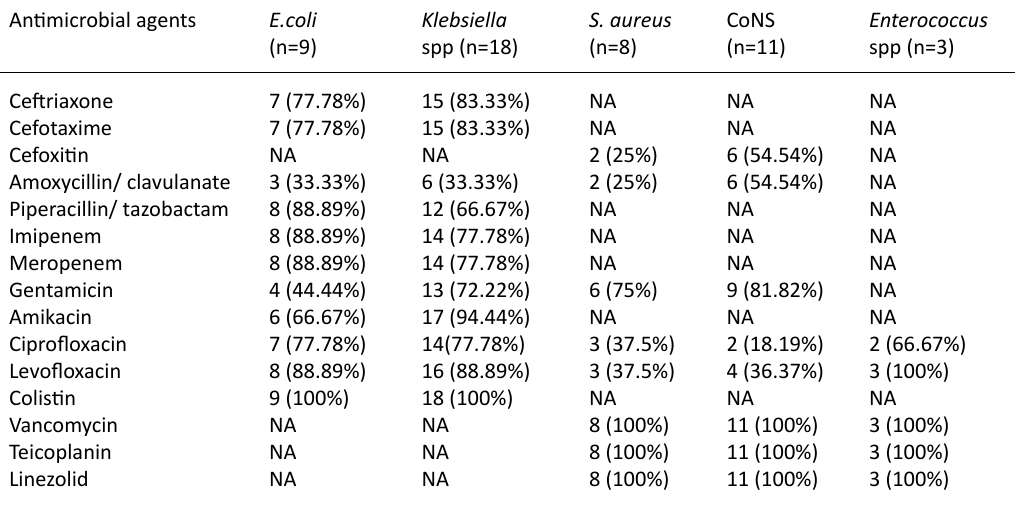
Table 7. Antimicrobial susceptibility pattern of the isolated bacteria Antimicrobial agents